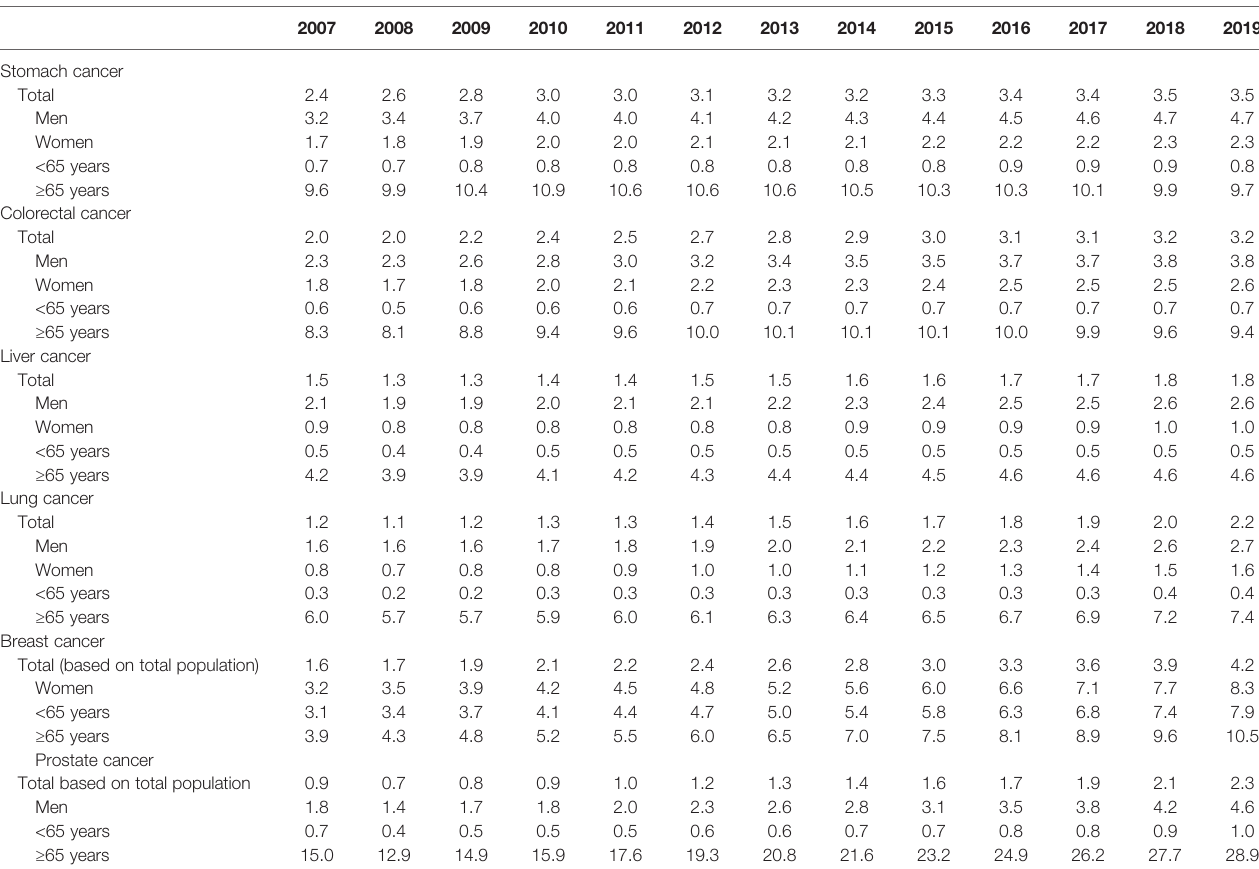
TABLE 1 | Trends in the cancer prevalence rate by cancer site, sex, and age (no. of patients per 1,000